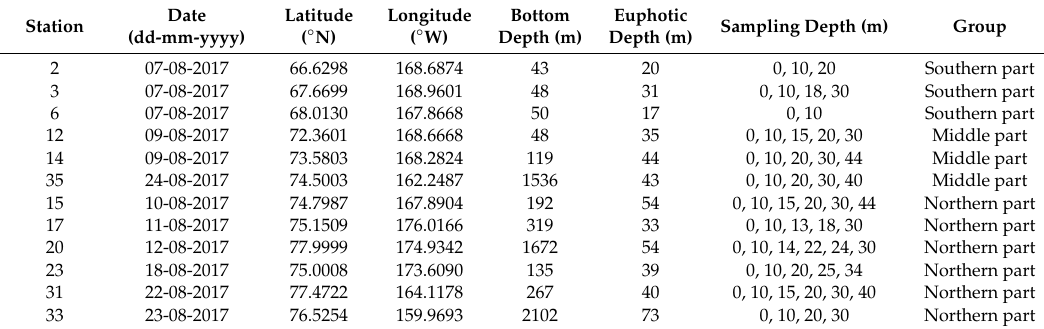
Table 1. Description of sampling stations in the Chukchi Sea, 2017. Euphotic depth is the depth of the 1% light level. All samples were collected from two to six di ff erent depths at each site within euphotic